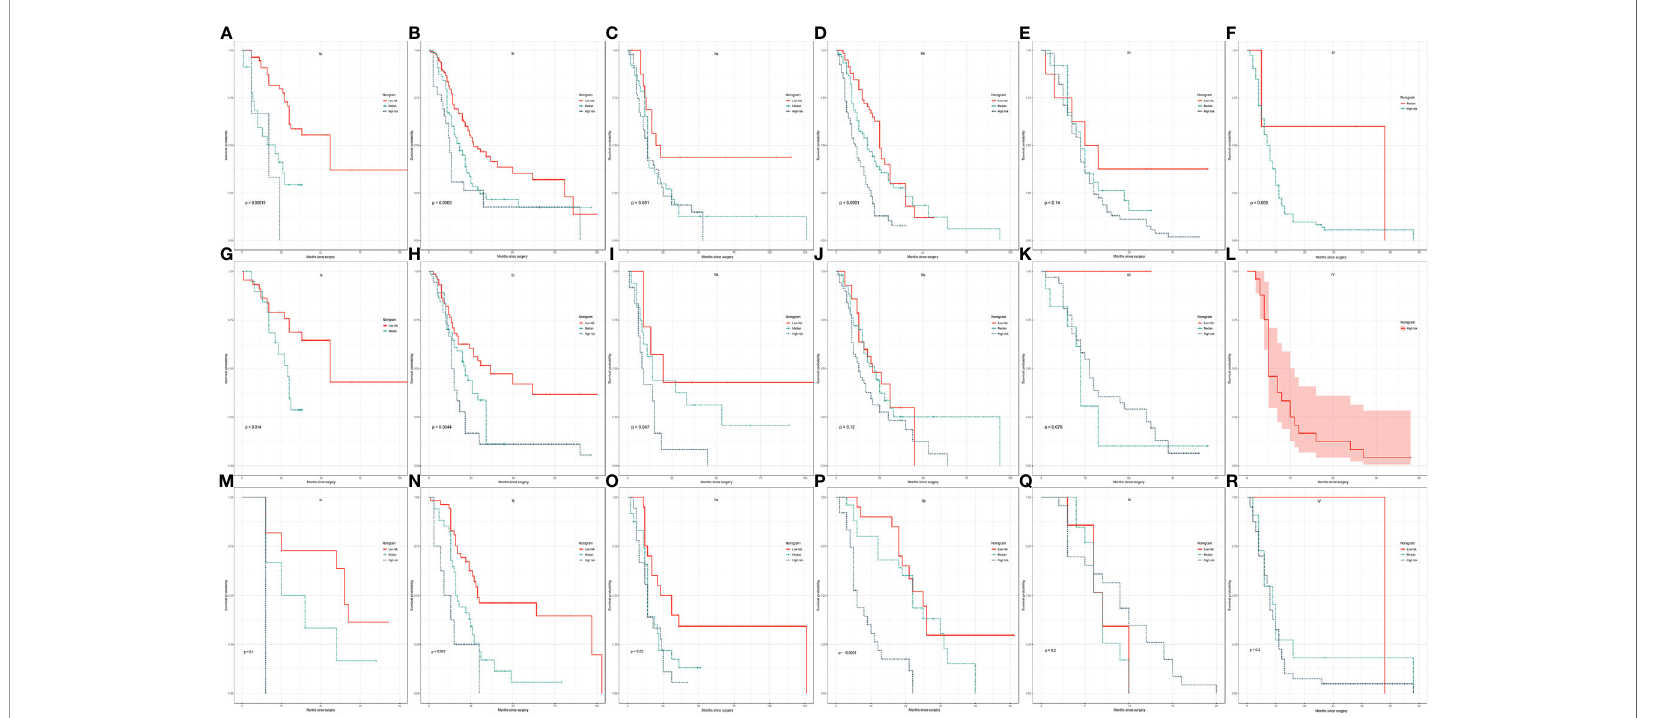
FIGURE 6 | Kaplan – Meier curve analysis of risk strati fi cation. Risk strati fi cation in the training cohort for each 8 th AJCC substage in the (A – F) PDAC group, (G – L) PHC group, and (M – R) PBTC group. The log-rank p values were <0.05 for (A, B, D, G, H, I, N – P)